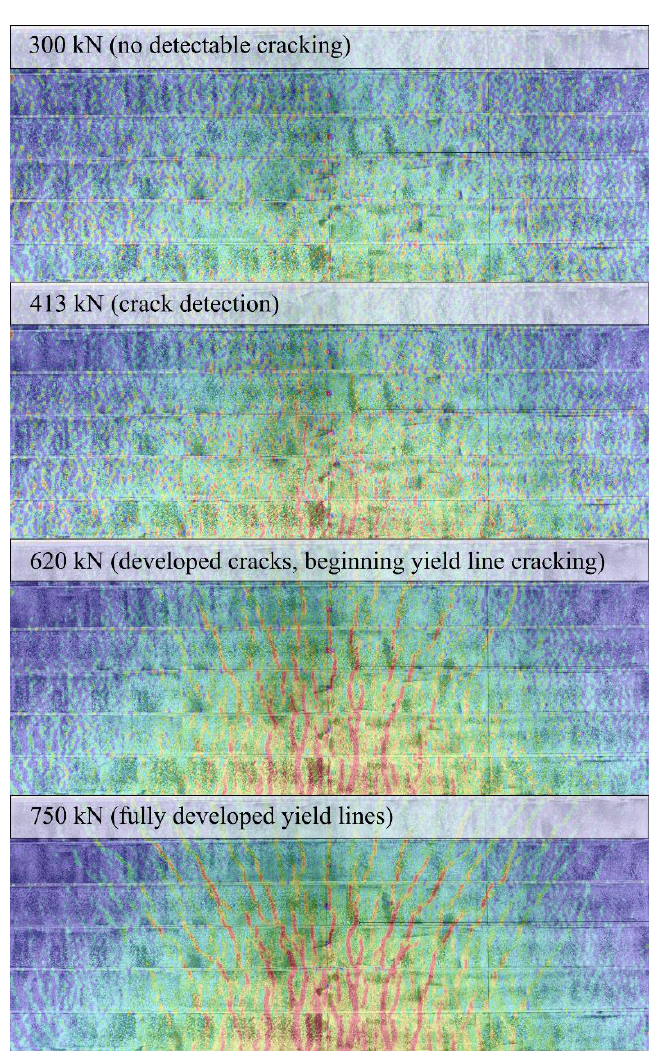
Figure 12. Lab test crack development stages.